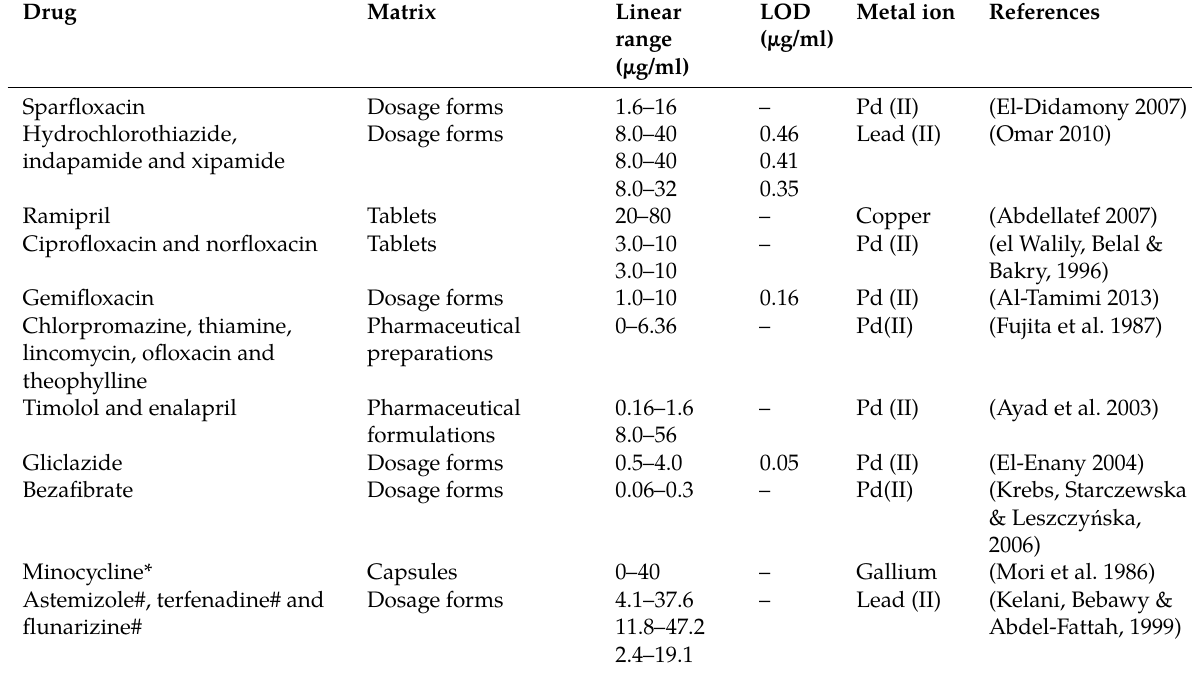
Table 2: Non-extractive spectrophotometric methods for the determination of pharmaceutical compounds based on the formation of ternary complex with eosin and metal ions in the presence or absence of methylcellulose as a surfactant. Drug